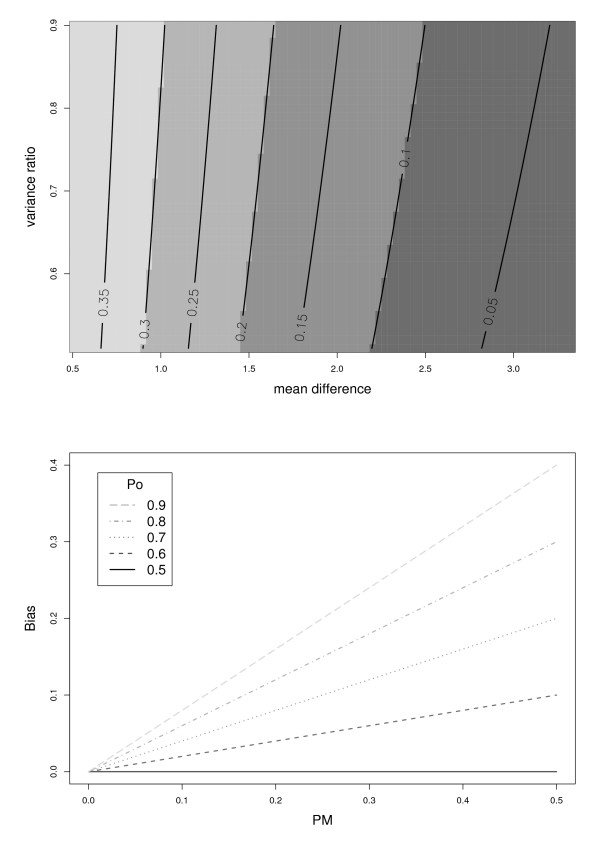
(PM and Bias) a) PM depends on the ratio, σ12:σ02 (y-axis) and on the difference, μ1 - μ0(x-axis) b) The bias, p0* - p0 (y-axis) depends on PM (x-axis), and is shown for different values of p0.